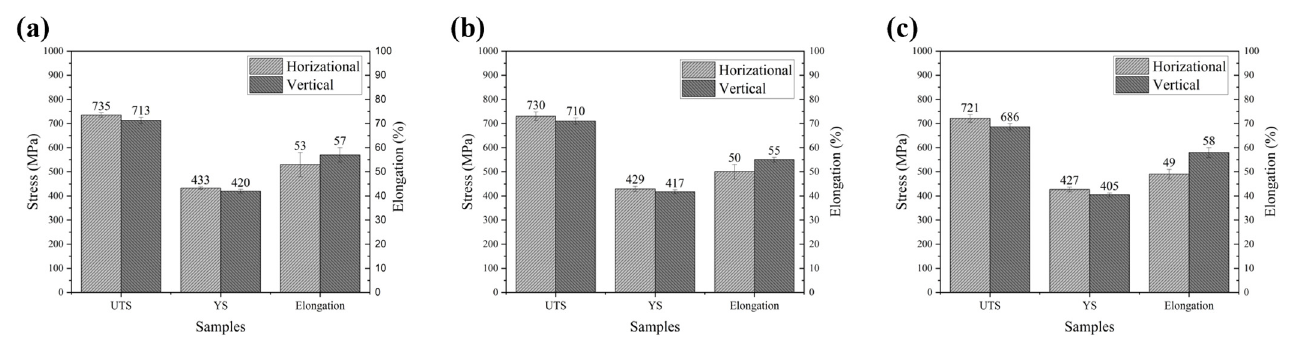
Figure 12. Tensile properties of as-deposited samples for different heat input were taken from horizontal (x–y plane) and vertical (y–z plane) directions: ( a ) ultimate tensile strength, ( b ) yield strength and ( c ) elongation. Table 5. Comparison of average tensile properties of Inconel 625 fabricated by using different pro- cesses.